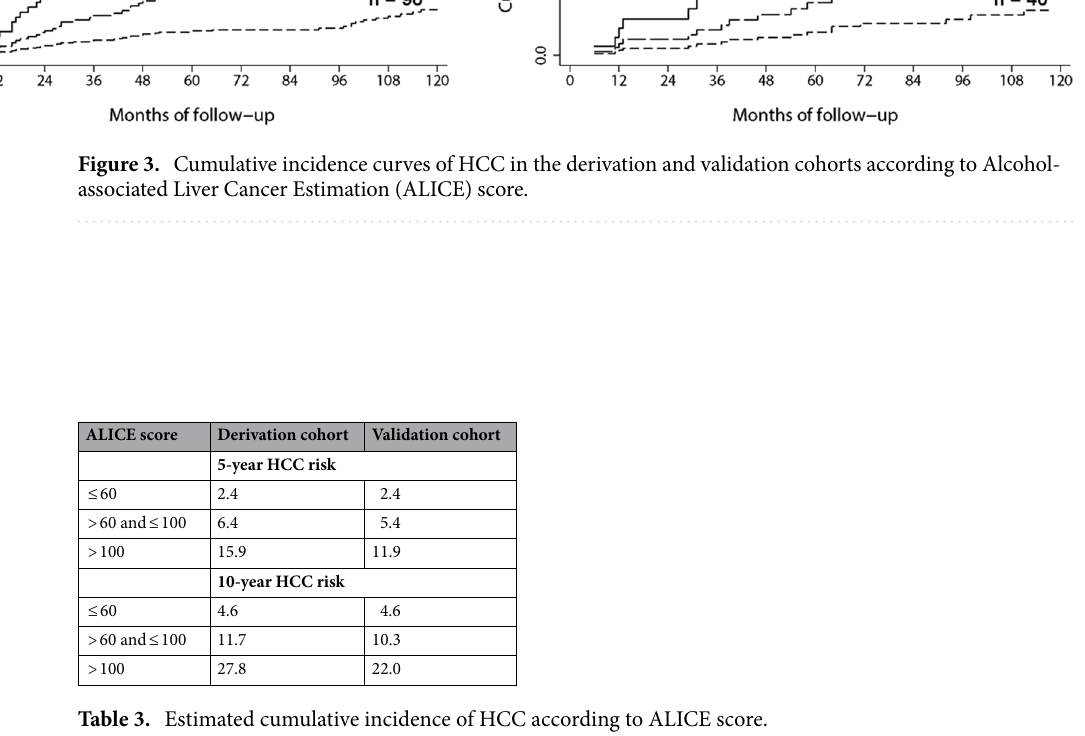
Table 3. Estimated cumulative incidence of HCC according to ALICE